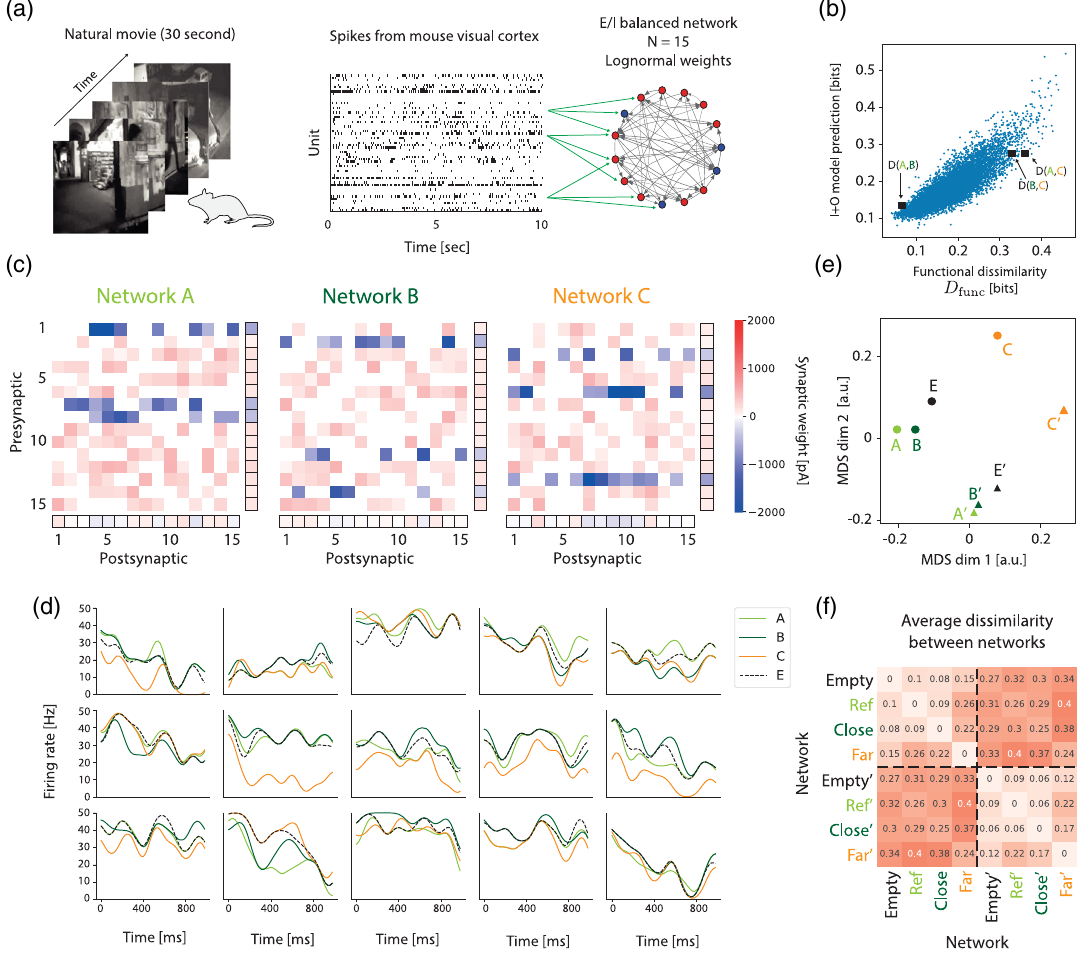
FIG. 6. Feature-based model predicts functional similarity under natural stimuli. (a) Our ensemble of networks are stimulated with spike trains recorded from mouse in vivo (see Sec. IV). Each neuron in the networks is stimulated by a randomly selected set of approximately 15 neurons out of the 59 recorded units from the visual cortex of a mouse presented with a 30-s-long natural movie. (b) The prediction of the feature-based I þ O model for the pairwise similarity of 10 000 balanced networks of 15 neurons, stimulated with spike trains as described in (a), is highly correlated with the functional similarity of the responses of networks, D . func (c) Connectivity matrices for three specific networks from the ensemble (described in the main text). Each entry is a synaptic weight (red, excitatory; blue, inhibitory). A and B have similar responses to the stimuli, as measured by D , while A and C have dissimilar func responses. The connectivity matrix of the empty network is not shown. The mean synaptic input (bottom) and output (right) of each neuron are shown for each network. (d) Firing rates of the 15 neurons in all four networks in the first second of the simulation, obtained by convolving individual spike trains with a Gaussian kernel ( A , green; B , dark green; C , orange; empty, black dashed line). Kernel standard deviation is 60 ms (three time bins). (e) 2D MDS embedding of networks A , B , and C , the “ empty ” network, and time-shuffled variants of their responses (denoted as A 0 , B 0 , C 0 , and empty 0 ; see the main text). (f) The functional dissimilarity matrix between a reference network (similar to A above), the functionally closest and farthest networks with the same number of inhibitory neurons (the same as B=C above), the empty network ( E above), and the shuffled variants of their responses, averaged over 100 reference [e.g., D ð A; A Þ ] as shown by multidimensional func shuffled scaling (MDS) embedding of the eight networks [Fig. 6(e)].